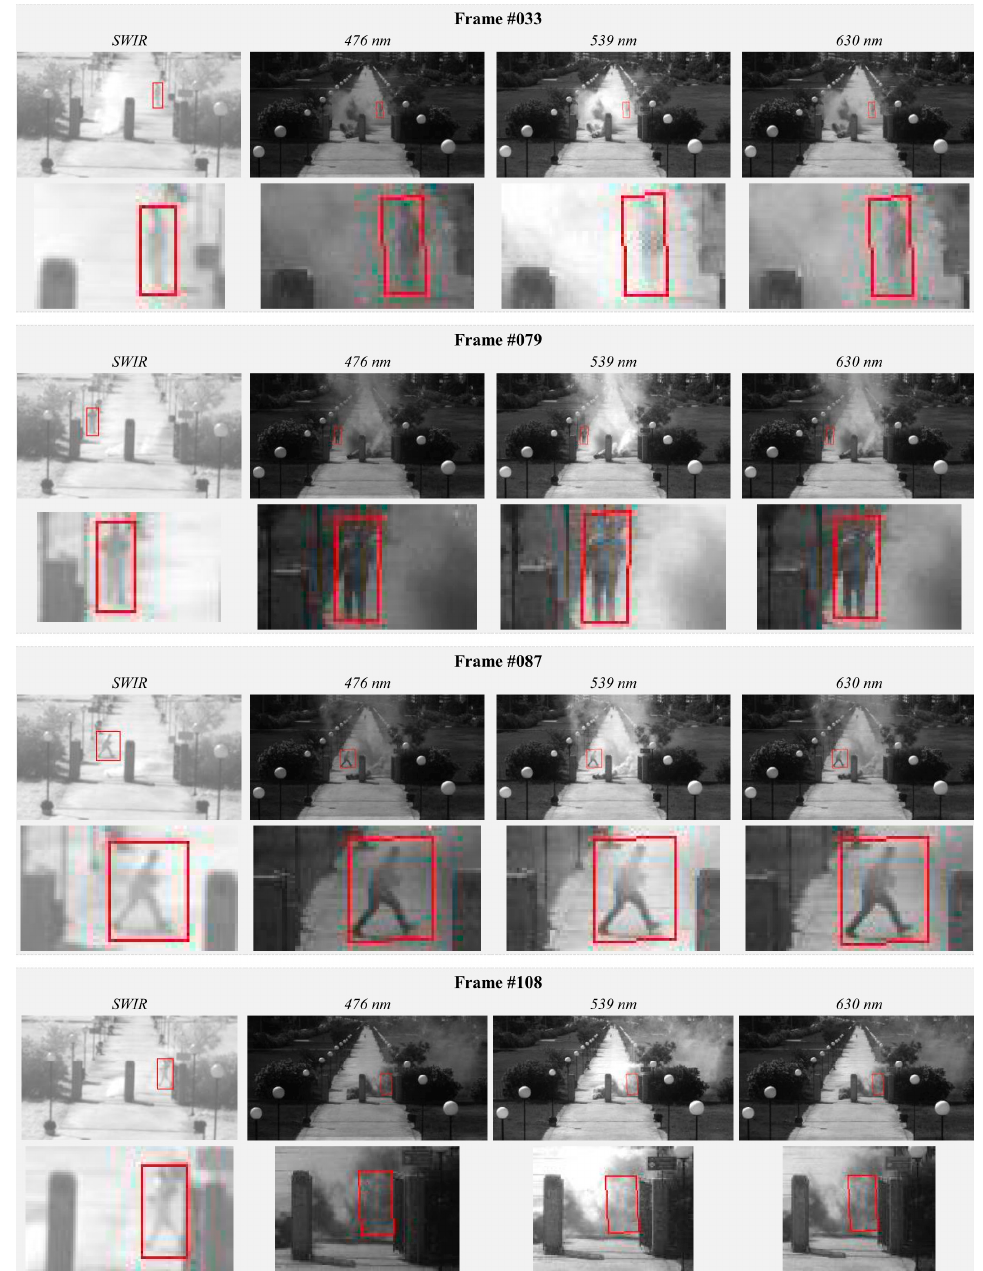
Figure 10. Experimental results after the application of the developed framework in the outD1 dataset (indicative frames #033, #079, #087, and #108). For each frame the SWIR and three hyperspectral bands (476, 539, and 630 nm) are presented. The detected targets are annotated with a red color onto the SWIR. Their projections are also shown onto the hyperspectral images. Zoom-in views are, also, provided.